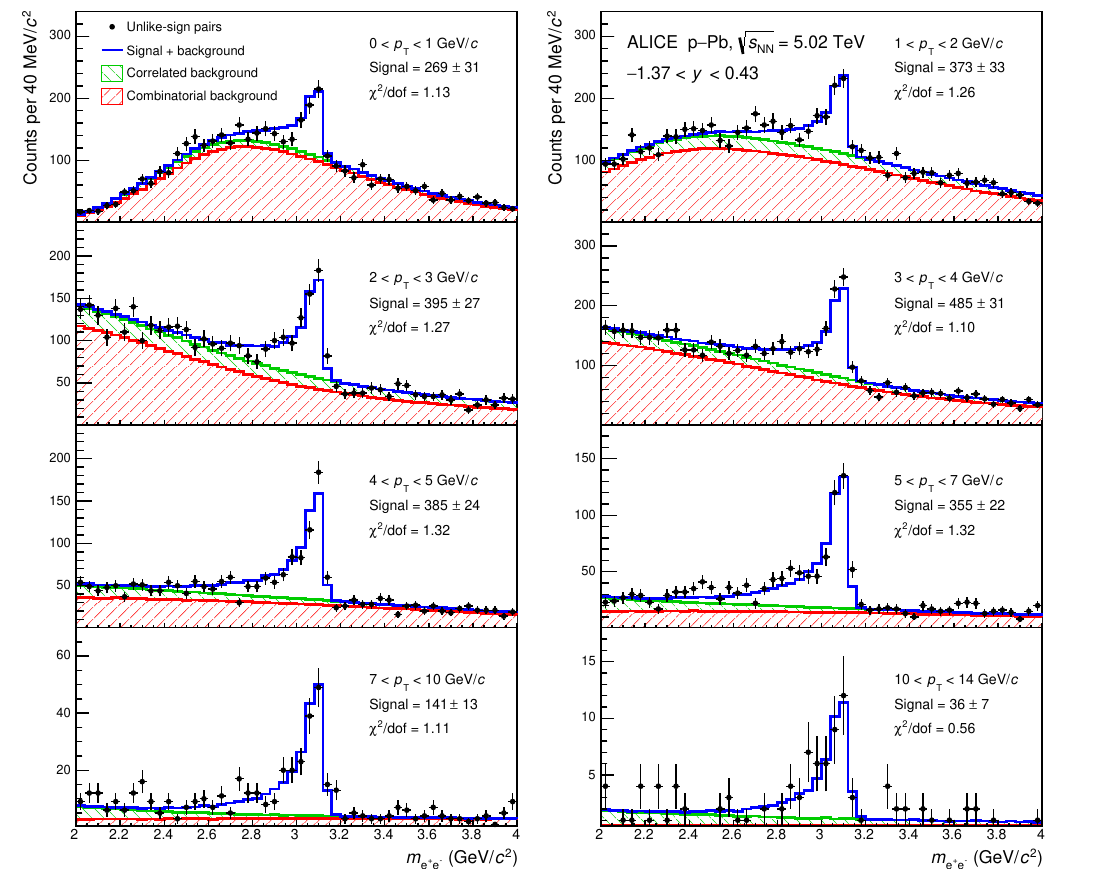
Figure 1 . Opposite-sign dielectron invariant mass distributions for the p -intervals used for this T analysis. The signal plus total background (blue), the combinatorial background (red), and the correlated background (green), evaluated as described in the text, are shown separately in each panel. The χ 2 / ndf values of the signal template plus the total background function are also reported along with the raw yields in the range 2 . 92 < m < 3 . 16 GeV/ c 2 e + e −